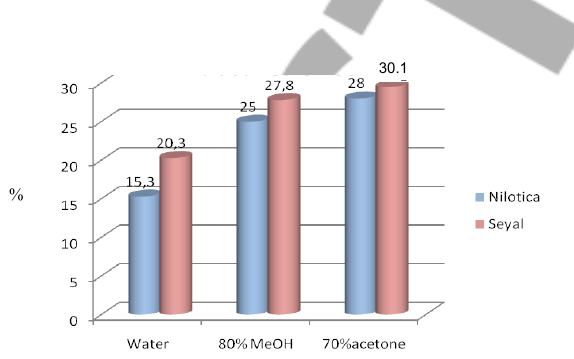
Figure 2 . Effect of extraction solvents (Unboiled) on the part of species of Acacia.